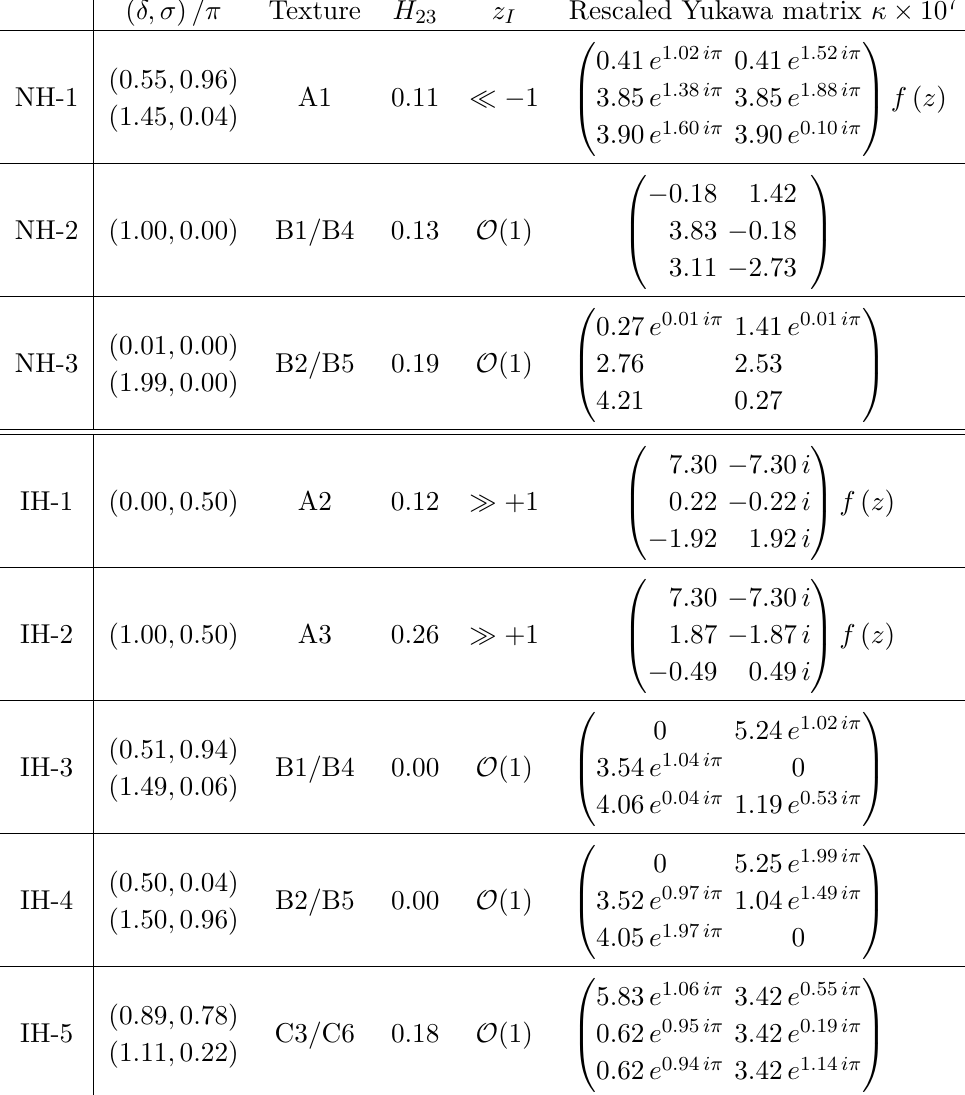
Table 2 . Minima of the minimized hierarchy parameter H 23 in the ( (cid:14); (cid:27) ) plane for normal and inverse light-neutrino mass ordering, respectively, see eq. (4.1). Nomenclature for the (approximate) textures according to eq. (2.14). Large values of j z I j correspond to (cid:13)avor alignment in the neutrino Yukawa matrix (cid:20) (cid:11)I , while O (1) values of j z I j do not imply any particular correlation among the two columns in (cid:20) (cid:11)I , see eq. (3.10). At large values of j z I j , all Yukawa couplings scale with f ( z )